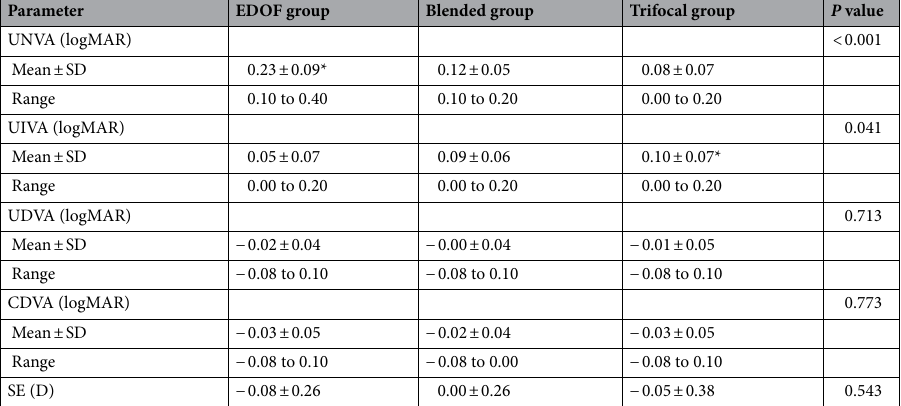
Table 2. Postoperative binocular visual acuity and spherical equivalent of the EDOF group, blended group and trifocal group. UNVA uncorrected near visual acuity, UIVA uncorrected intermediate visual acuity, UDVA uncorrected distance visual acuity, CDVA corrected distance visual acuity, SE spherical equivalent, logMAR logarithm of the minimum angle of resolution, D diopters, SD standard deviation. P < 0.05 means statistically significant difference. *means statistically significant difference compared with other groups.